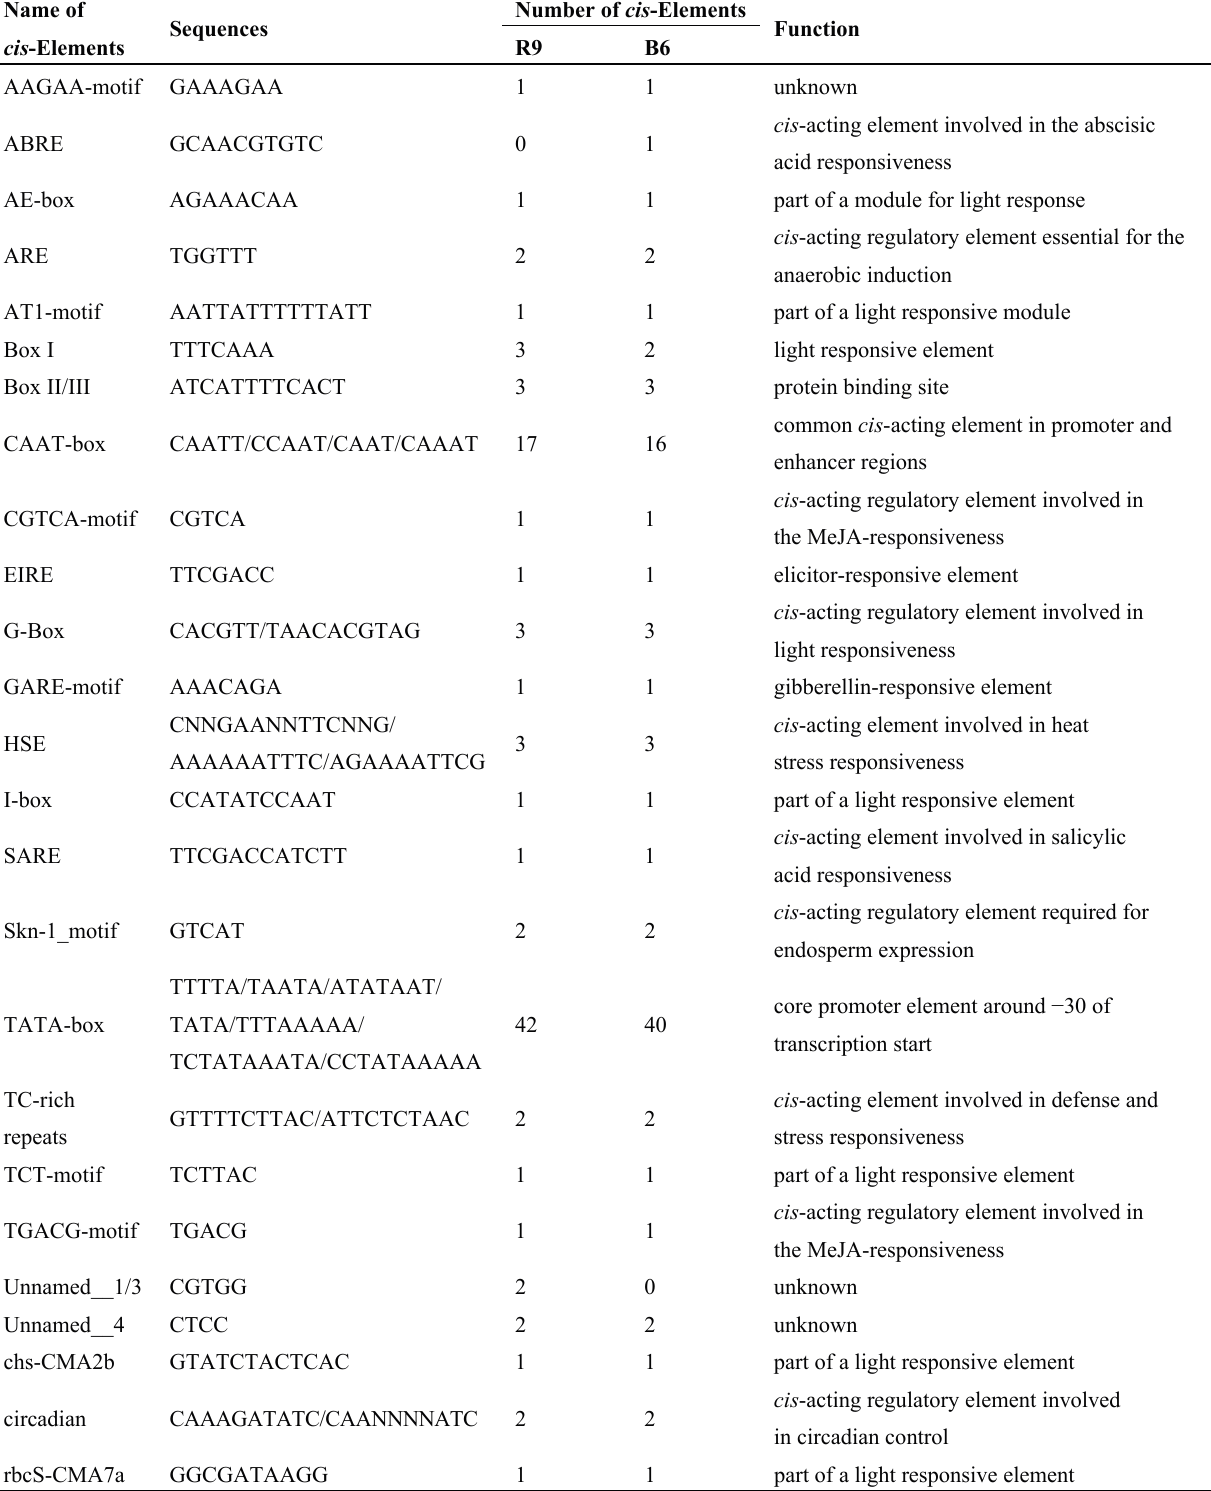
Table 1. cis -Elements in promoters of CaHsp70-1 from B6 and